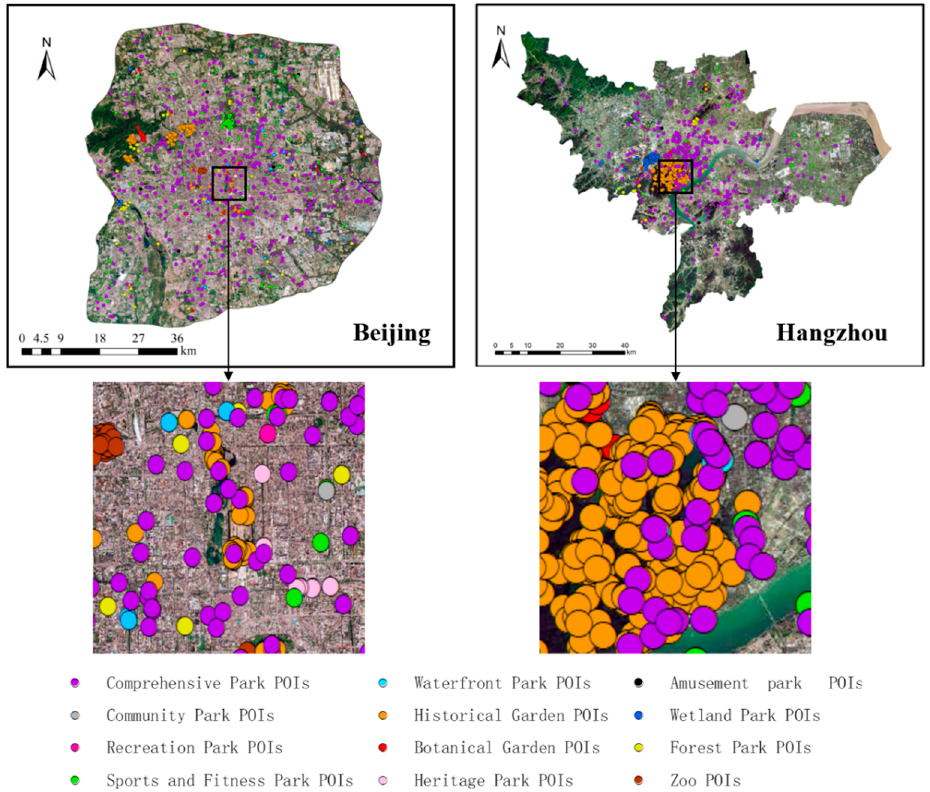
Figure 7. Classification results of urban parks using POI data.